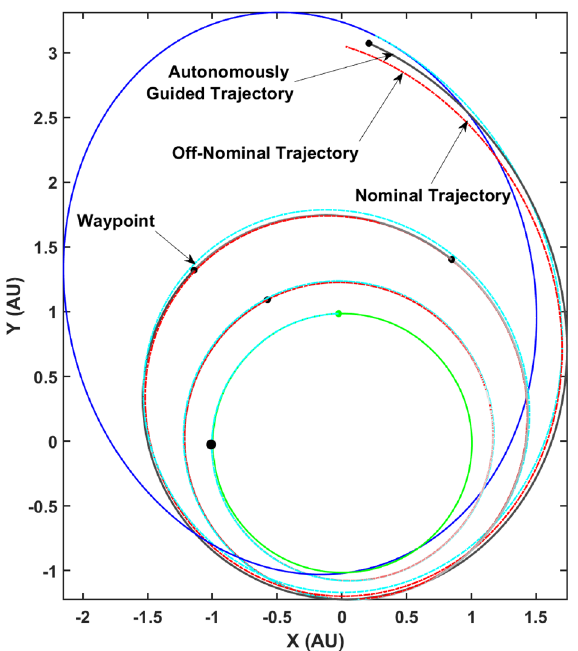
Figure 11. Autonomously guided trajectory with re-planning at the N t